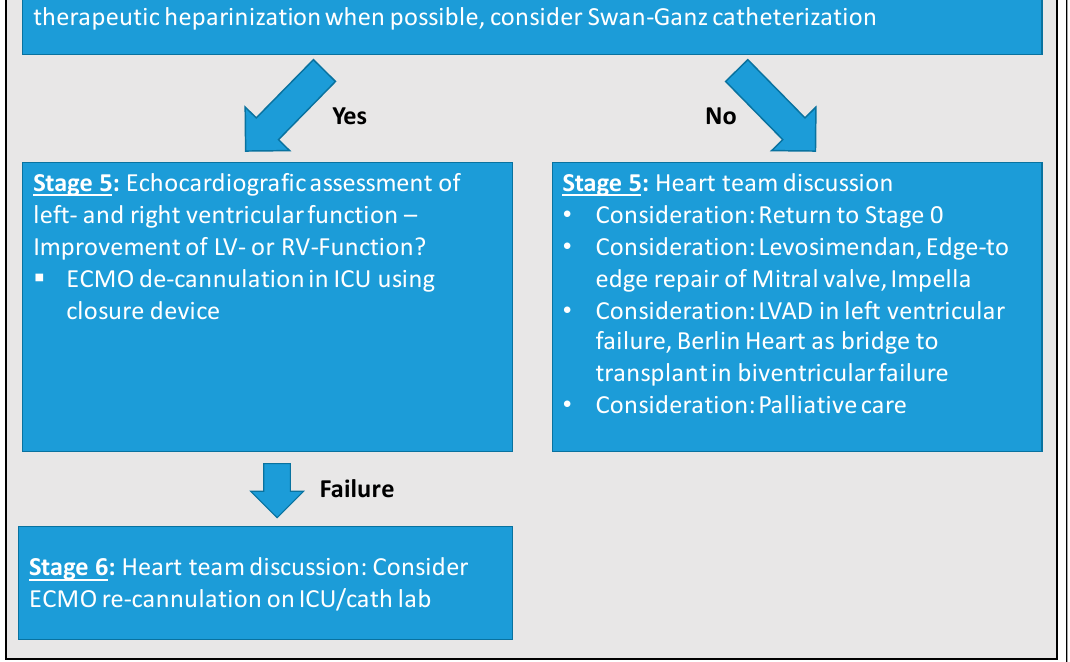
Figure 7. VA-ECMO Weaning—University Hospital Munich, a cardiologic ICU. MAP, mean arterial pressure; ScvO 2 , central venous oxygen saturation; SaO 2 , arterial oxygen saturation; PaO 2 , partial pressure of oxygen; FiO 2 , fraction of inspired oxygen.